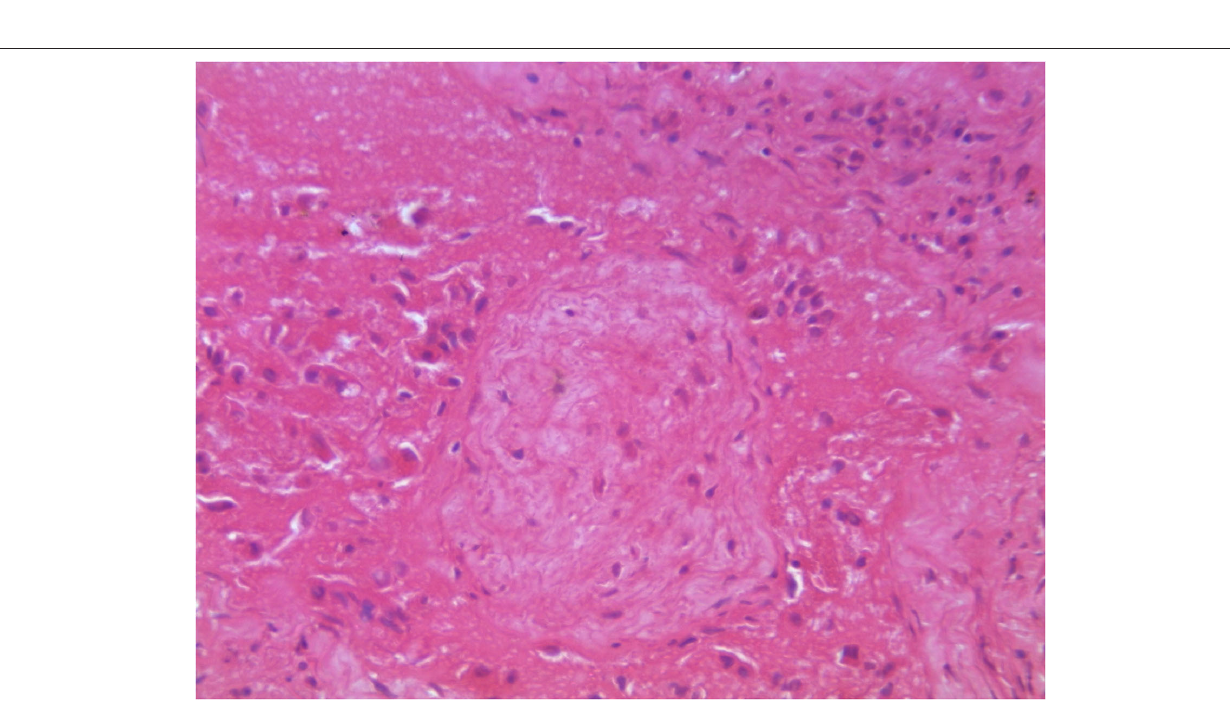
Frontiers in Veterinary Science |